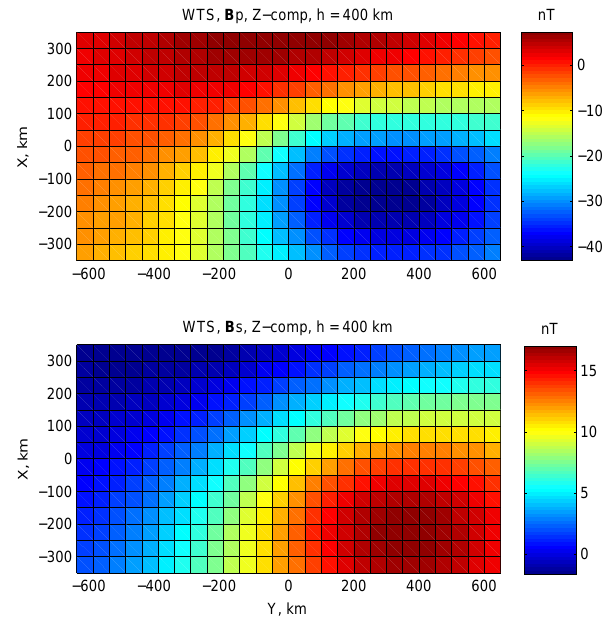
Fig. 14. Same as Fig. 12, but for the WTS